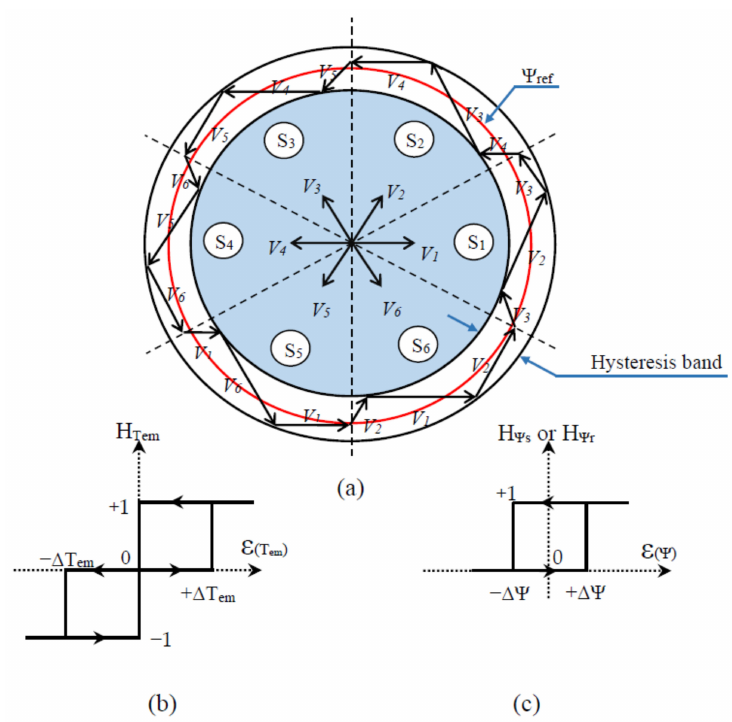
Figure 1. ( a ) Fluxes trajectory, ( b ) three-level torque hysteresis comparators, and ( c ) two-level fluxes comparators.